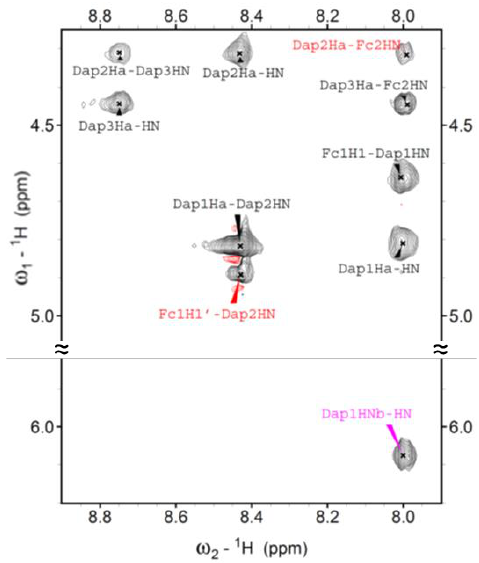
Figure 4. Region of the NOESY spectrum of 3 solution, T = 25 °C.